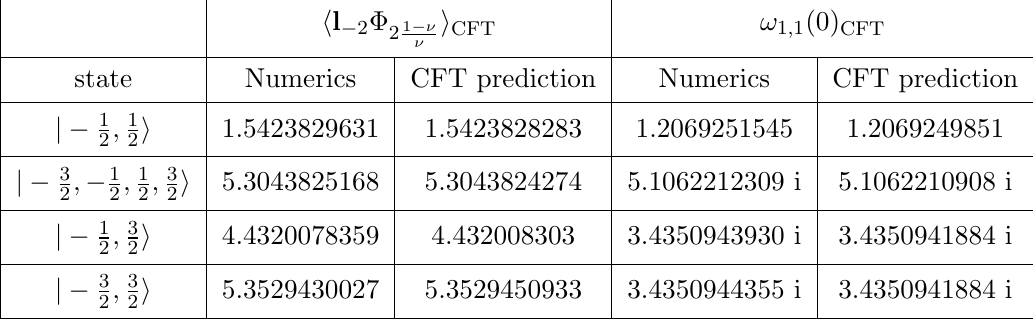
2(1 (cid:0) (cid:23) ) =(cid:23)